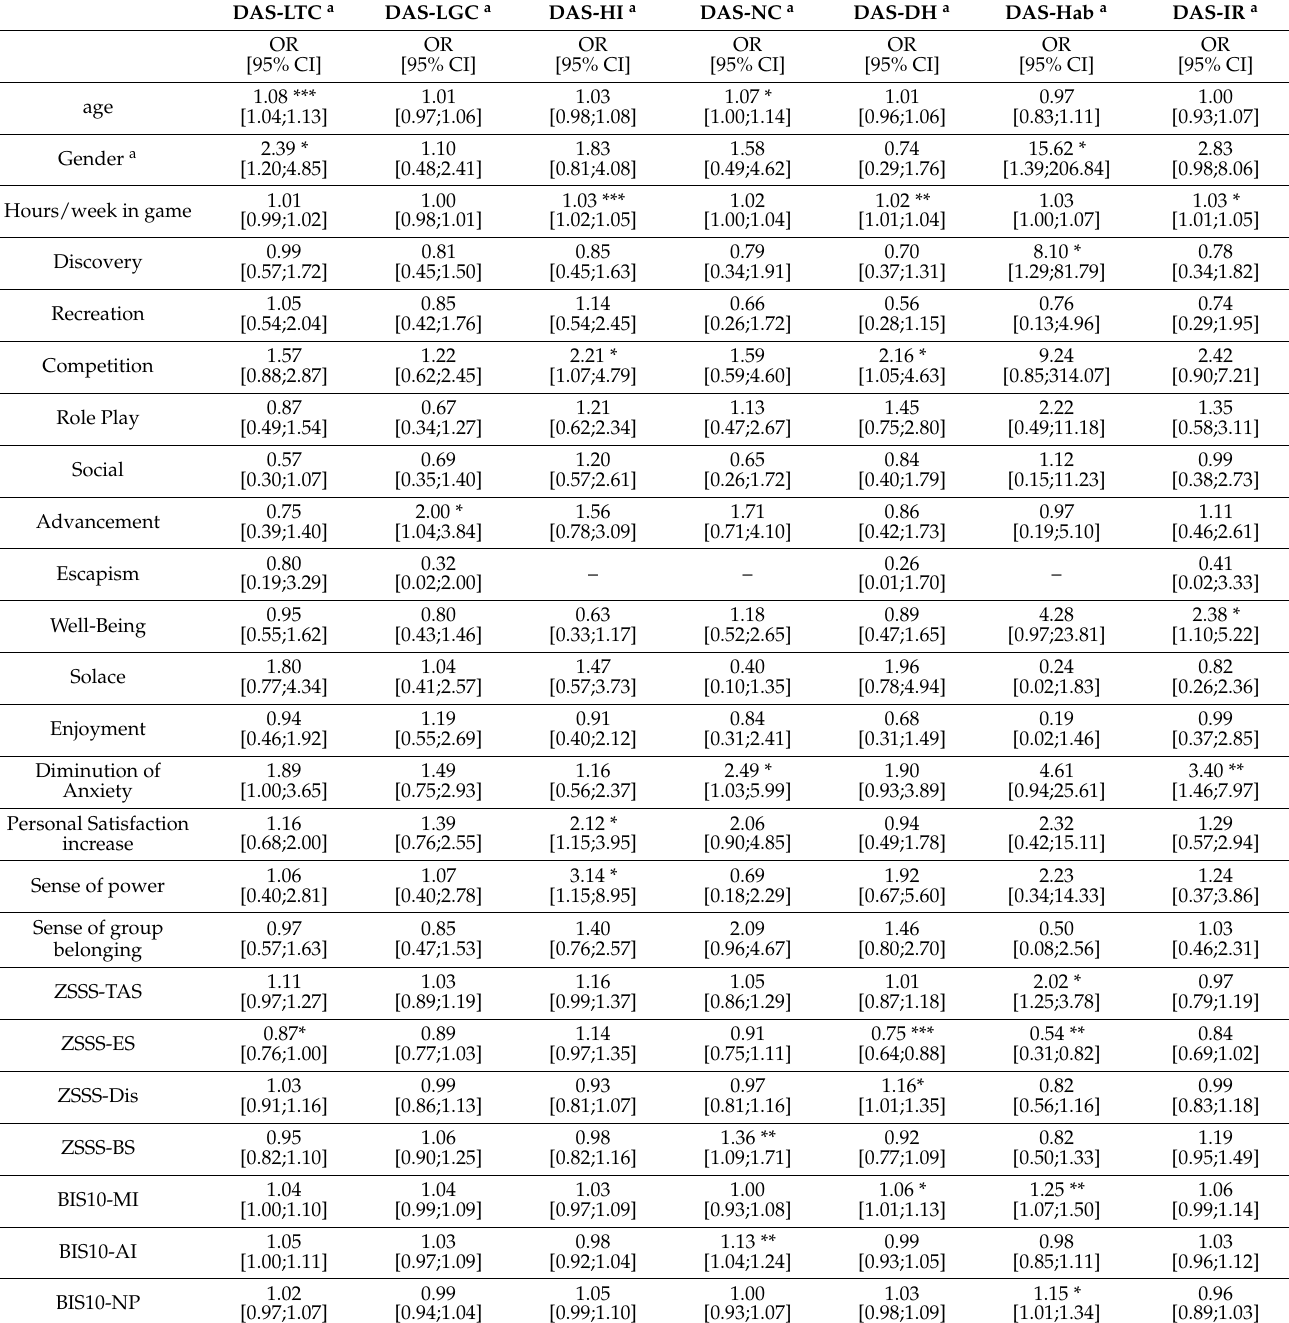
Table 2. Logistic regression results (N =